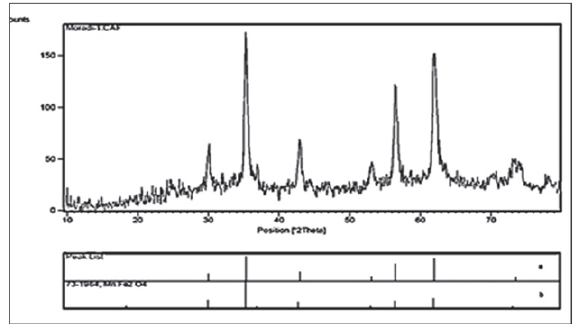
Figure 3. The X-ray diffraction patterns of the prepared MnFe 2 O 4 NPs.